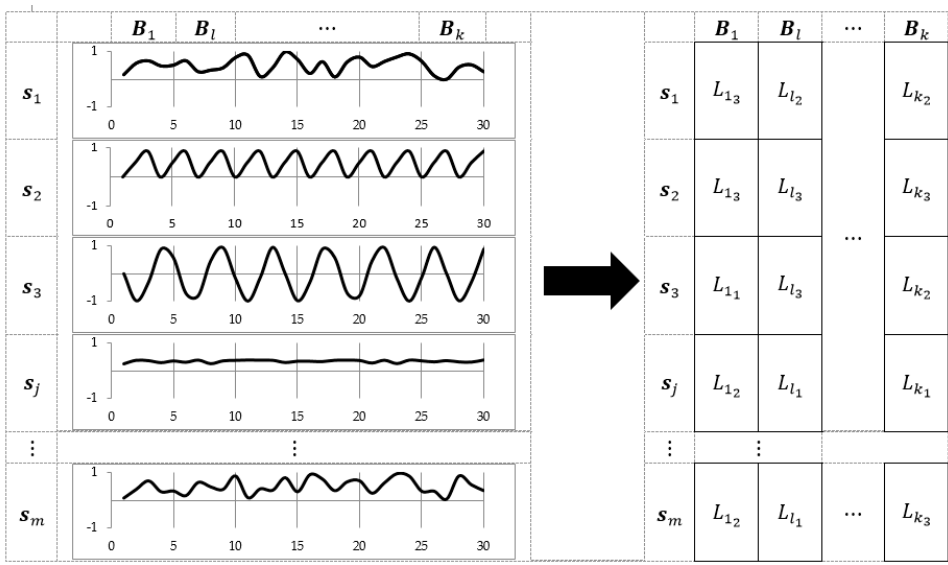
Figure 1. An exemplary data representation model with clustering .